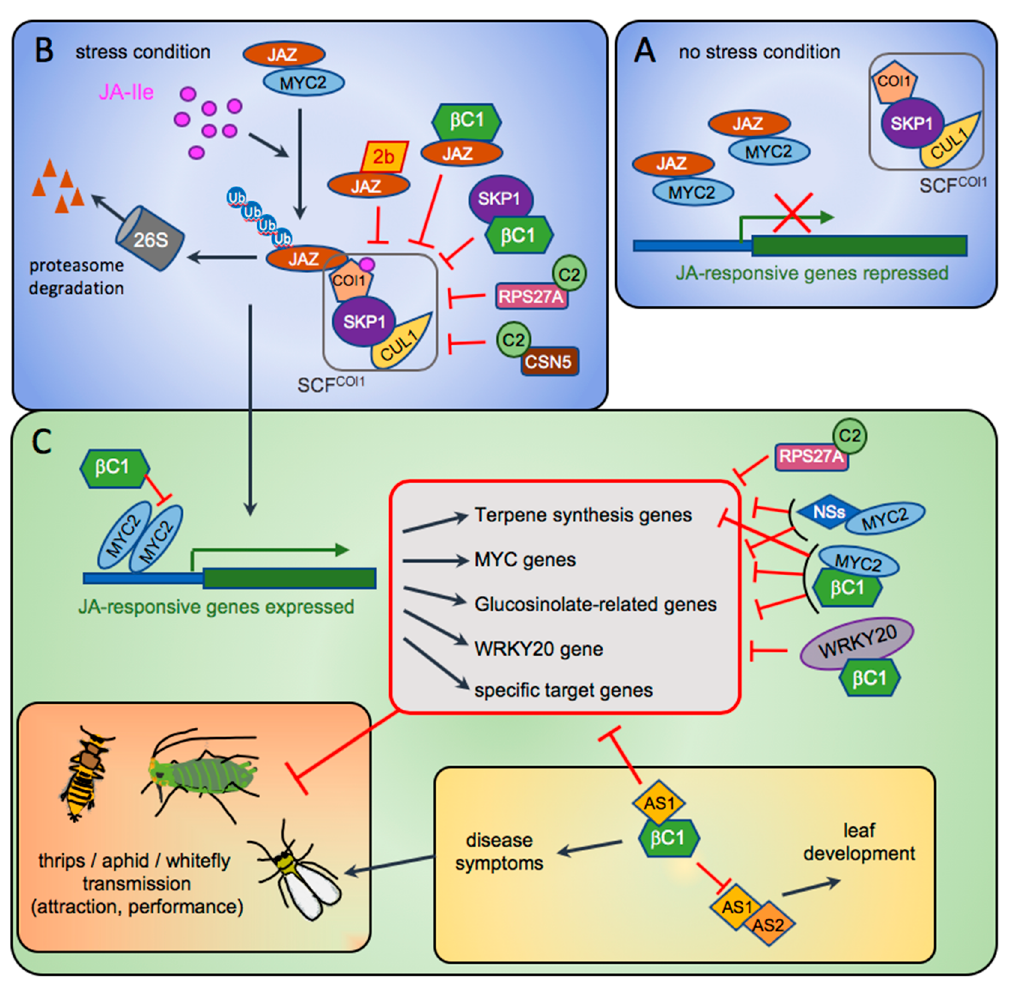
Figure 1. Model depicting the known targets of Cucumber mosaic virus (CMV)-2b, Tomato spotted wilt virus (TSWV)-NSs and begomovirus C2 and β C1 proteins in the pathways regulating plant defences and symptomatology. ( A ) In non-stressed conditions, the level of active jasmonate, Jasmonoyl-Isoleucine (JA-Ile), is very low. JAZ repressors bind to MYC2 to repress its transcriptional activation on downstream genes of the JA signalling pathway. ( B ) Under herbivore insect attack, the strong increase of JA-Ile triggers the assembly of a JAZ-COI1 co-receptor that will be recruited by the E3-ubiquitin ligase SCF COI1 (SKP1 / Cullin / F-box). JAZ repressors will undergo ubiquitination and be addressed to the 26S proteasome for degradation. ( C ) The transcription factor MYC2 and others are released and can activate the genes involved in JA response, like those in terpene biosynthesis, glucosinolate production, and other responses (grouped in the red box). During viral infection, viral suppressors of RNA silencing are produced and can antagonise some of these responses. Here are shown four of them, the CMV-2b (panel B), the begomovirus C2, the begomovirus satellite β C1 (panels B and C) and the tospovirus NSs (panel C), interacting with their known targets compromising the SCF COI1 complex activity (panel B) or some specific gene activations (panel C). Red bar-heads indicate the inhibitory e ff ect of the viral proteins. The regulations between the various host genes are not reported.